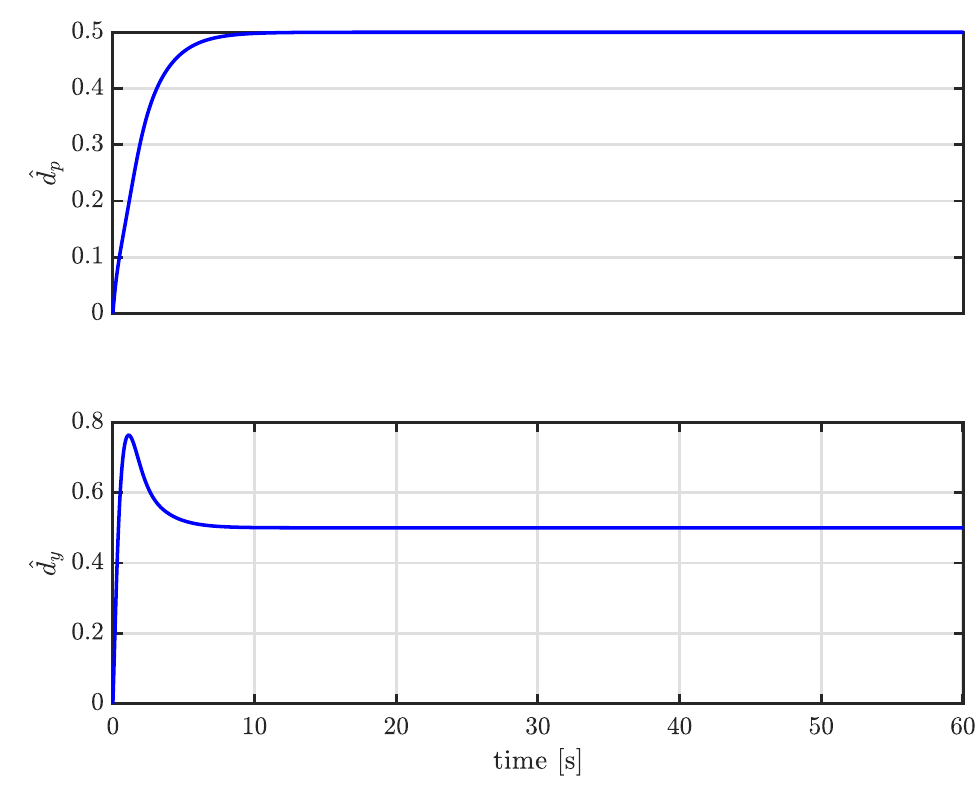
Figure 10. Estimated disturbances (Case II-simulation).